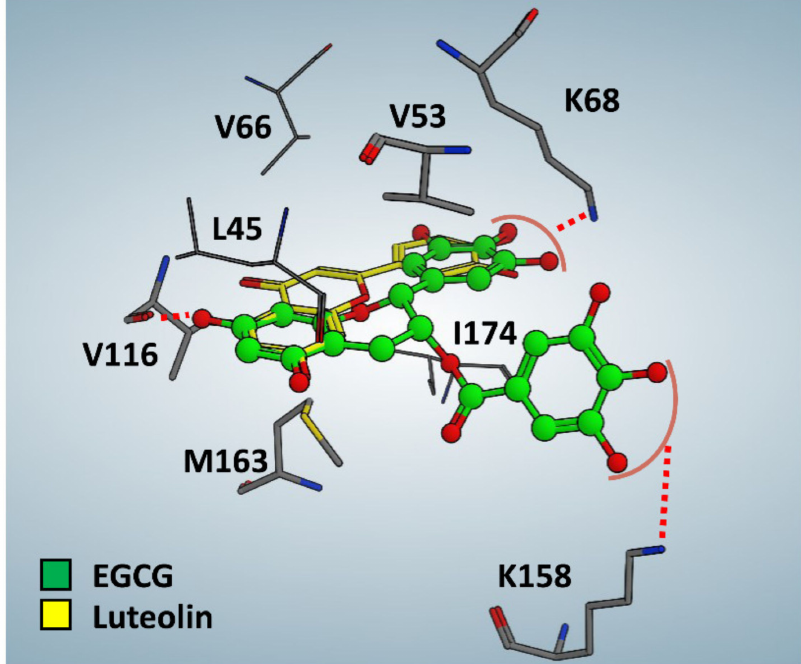
Figure 5. Docking analysis of EGCG in complex with human protein kinase CK2 α catalytic subunit. The best docking conformation of EGCG (green) compared to the crystallographic pose of luteolin (PDB code: 4DGN, yellow) is